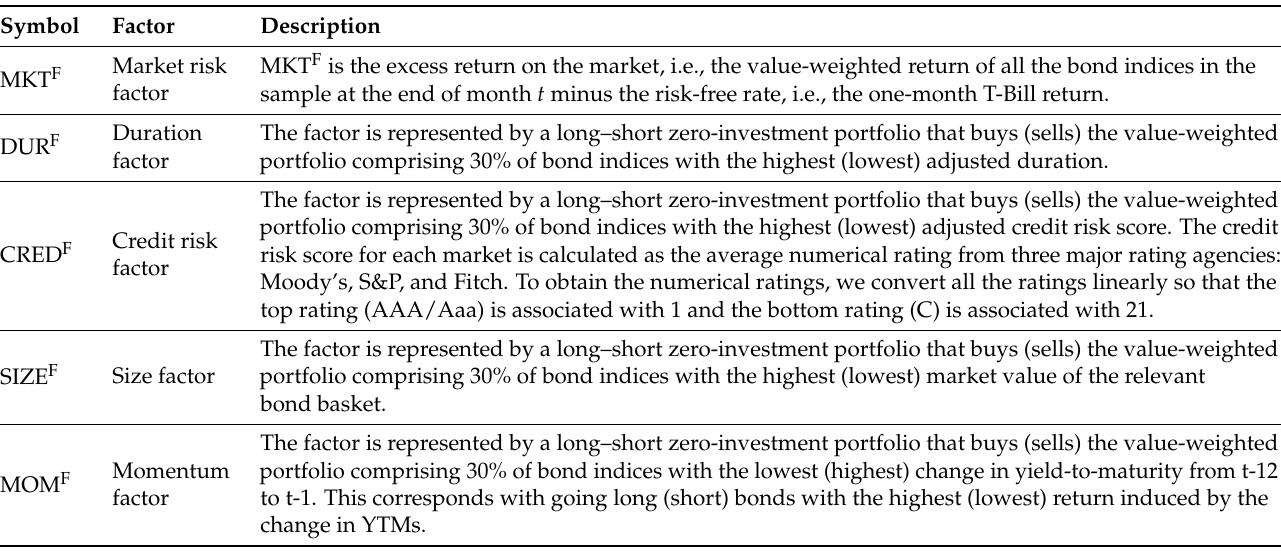
Table A1. Construction of the Cross-Sectional Asset Pricing